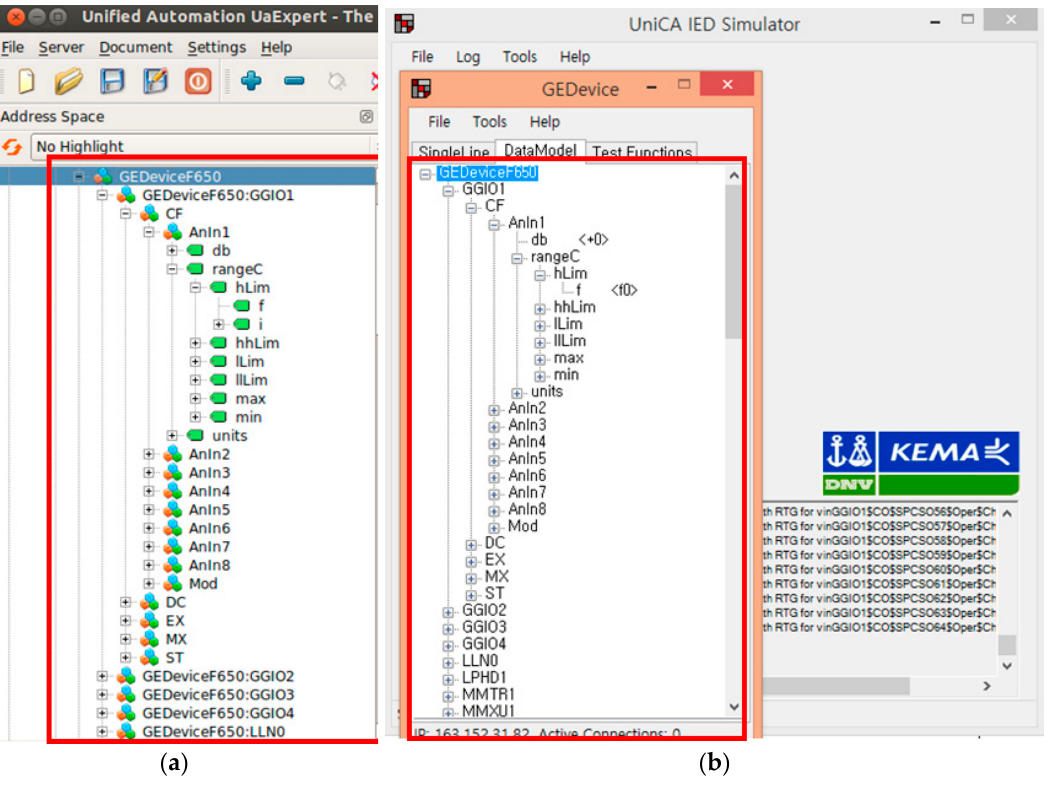
Figure 13. Results of IEC 61850–OPC UA interconnection. ( a ) UA’s Expert tool (OPC UA client); ( b ) KEMA’s UniCA IED (intelligent electronic device) Simulator (IEC 61850 server).